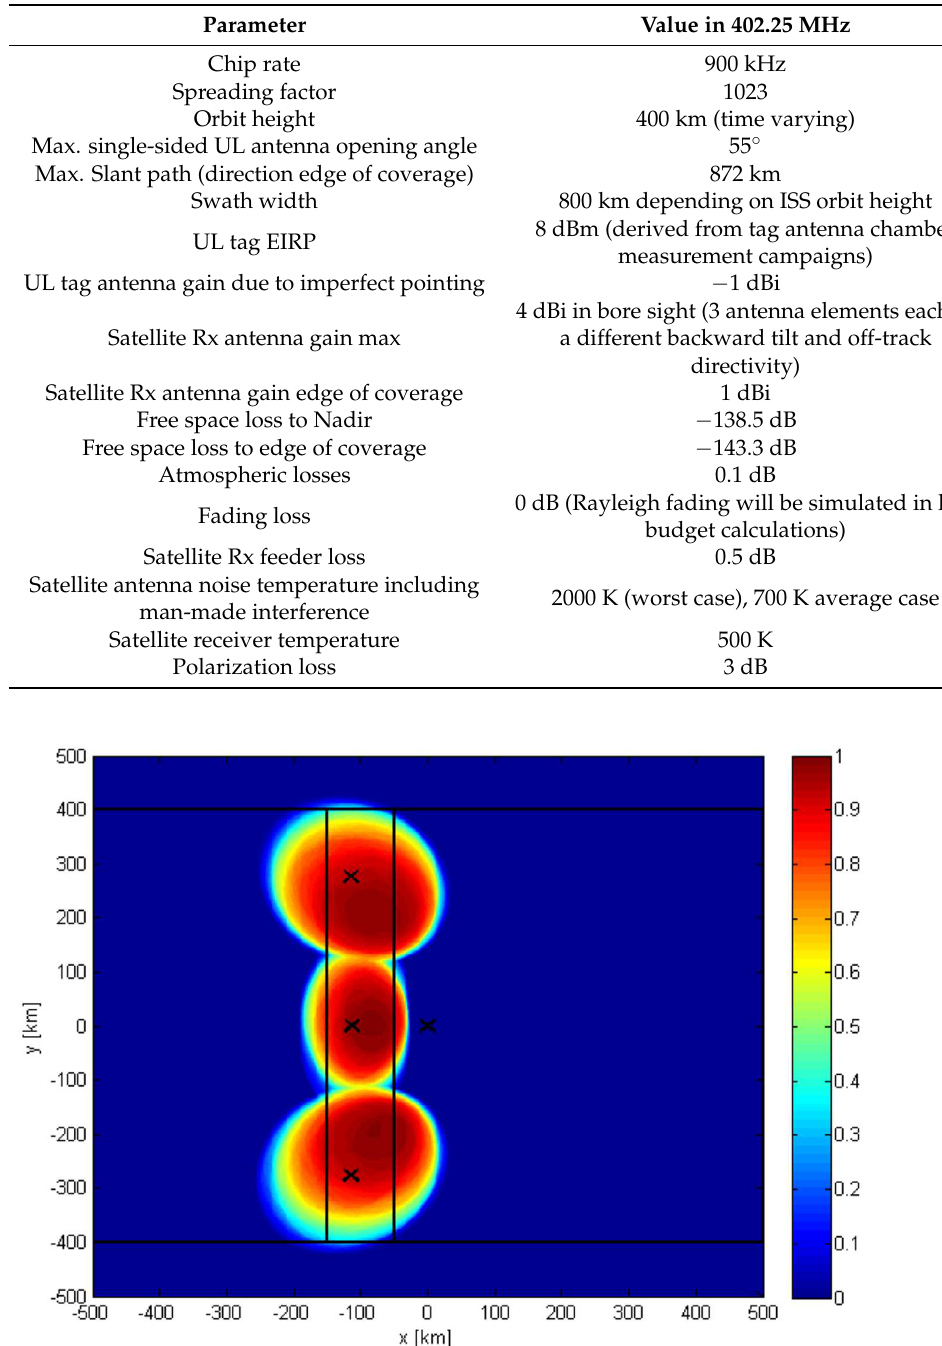
Table 5. ICARUS UL Link Budget.